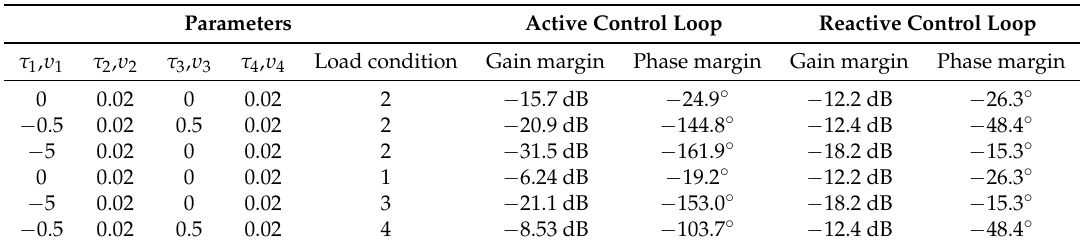
Table 1. Phase and Gain Margin of Active Power Control Loop and Reactive Power Control Loop in Different Scenario.